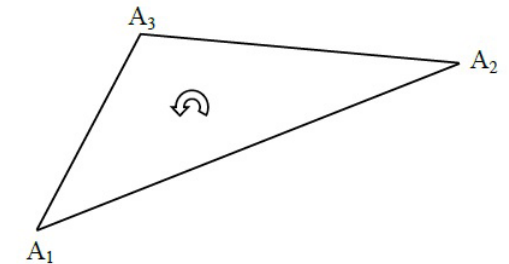
Figure 7: Sign of the expression.